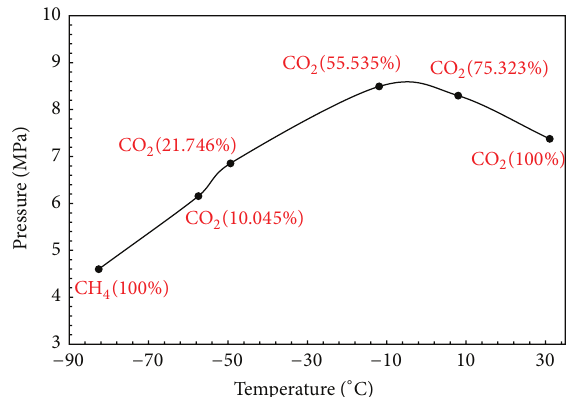
Figure 14: Variation curve of the critical points of natural gas with different CO 2